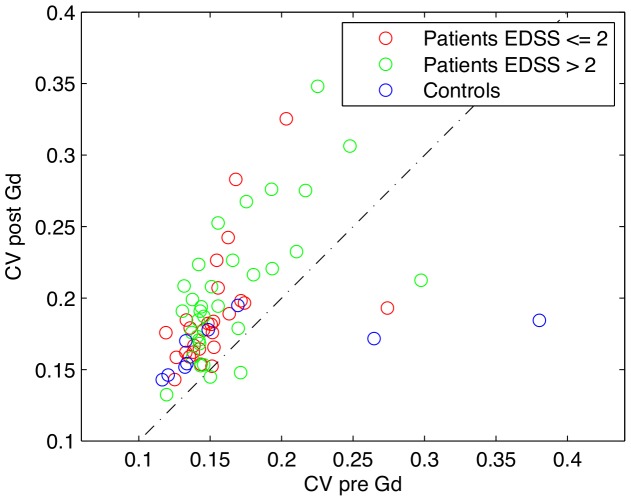
Coefficient of variation before and after the injection of contrast agent.For each healthy control and each patient, the coefficient of variation (CV) of the white matter and NAWM, respectively was calculated. Each subject is thus represented by a marker in the corresponding position (the dotted line represents y = x). It seems that the CV of the patients are generally increased after the injection of the contrast agent.